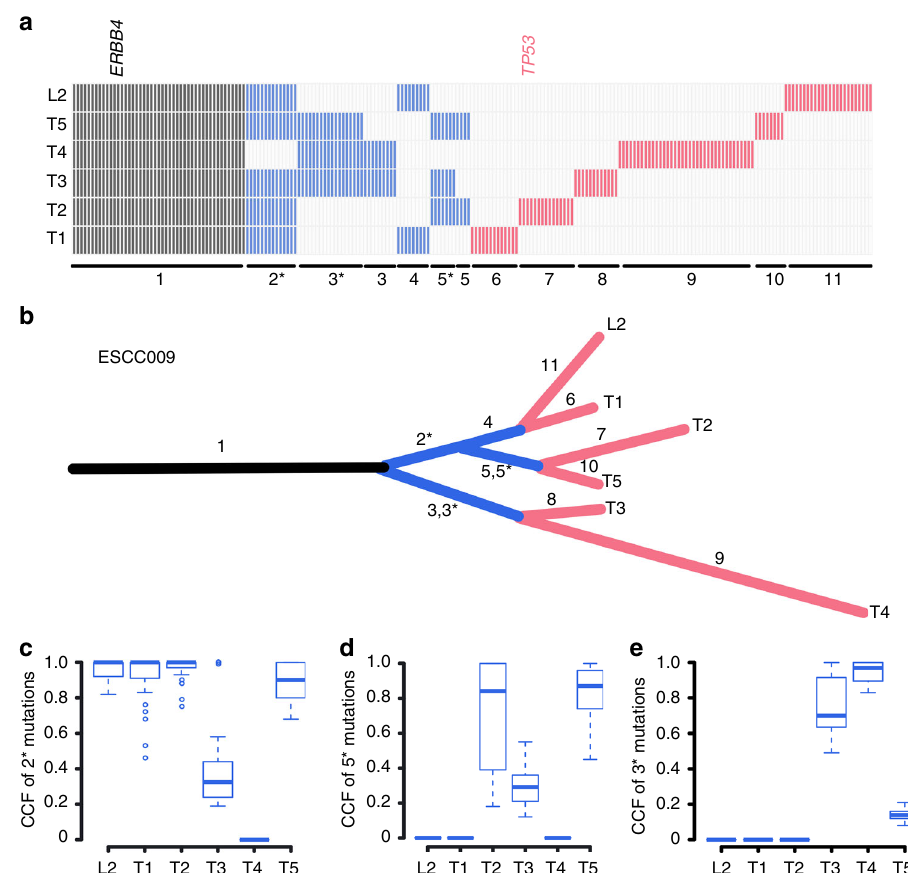
Fig. 5 Evolutionary patterns within ESCC009. a The distribution of non-silent mutations in different regions of case ESCC009. b Phylogenetic tree of ESCC009 based on somatic SNVs. Black: trunk; blue: shared branches; red: private branches. c – e The CCF of somatic SNVs in speci fi c shared